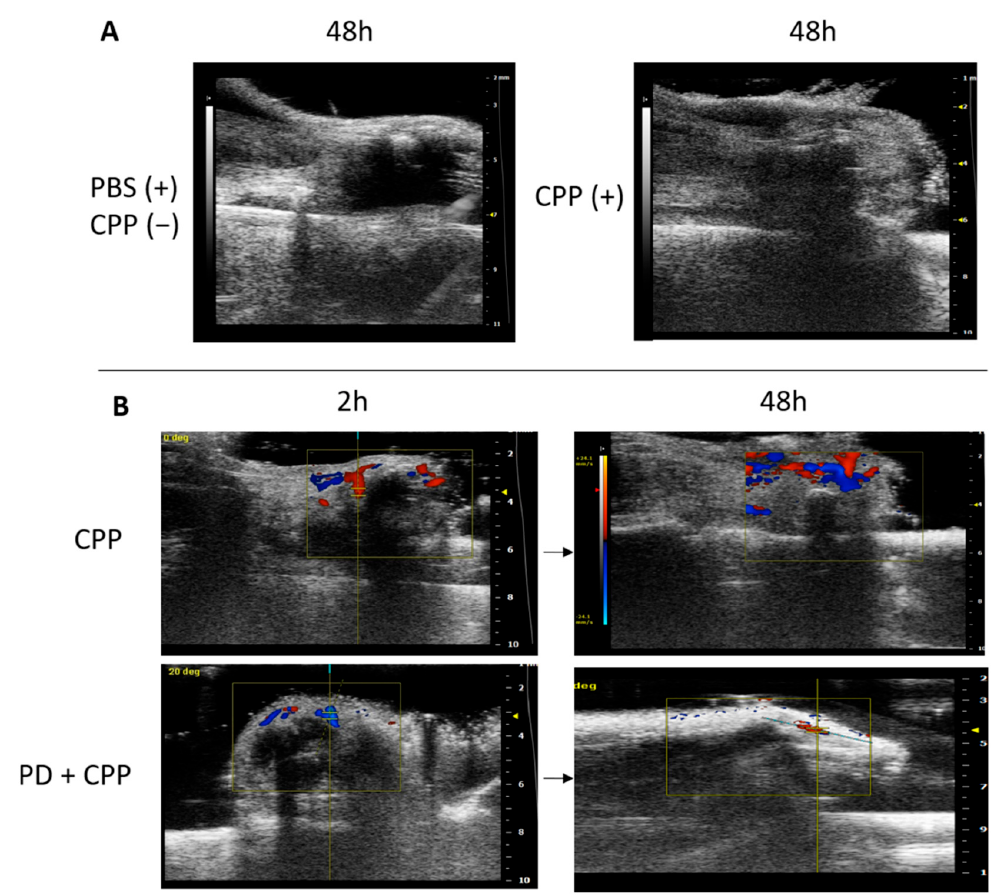
Figure 8. Ultrasound images of the right ankle joint obtained before and after CPP crystal injection and according to prophylactic treatment with polydatin. US performed on mice under anesthesia 48 h after PBS or CPP crystal (0.3 mg/mL) injection ( A ). Power Doppler US detection of hyperemia 2 h and 48 h after crystal injection ( B , first line). Effect of prophylactic treatment with PD (40 mg/mL) on vascular changes caused by the crystals ( B , second line).